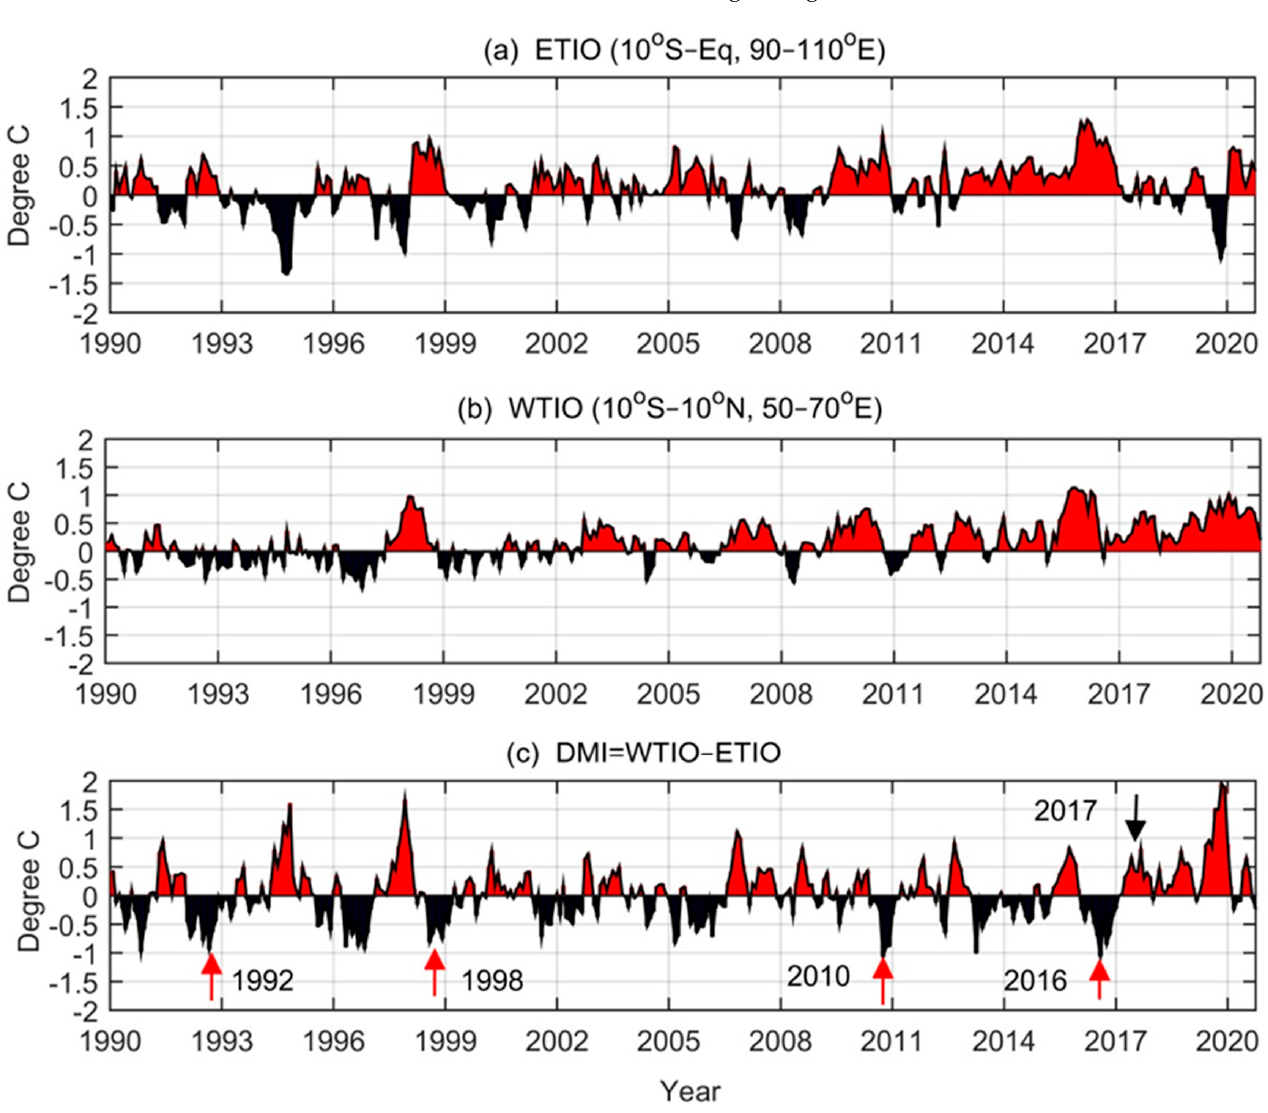
Figure 4. Time series of average SST anomalies in the ( a ) ETIO (10° S–Eq, 90–110° E), ( b ) WTIO (10° S–10° N, 50–70° E), and ( c ) IOD index (DMI=WTIO − ETIO). Data were derived from Extended Reconstructed Sea Surface Temperature version 5 (ERSST.V5) from 1990 to 2020. The red arrows indicate that negative IOD events occurred during El Niño. The weak positive IOD event in 2017 is indicated by black arrow.